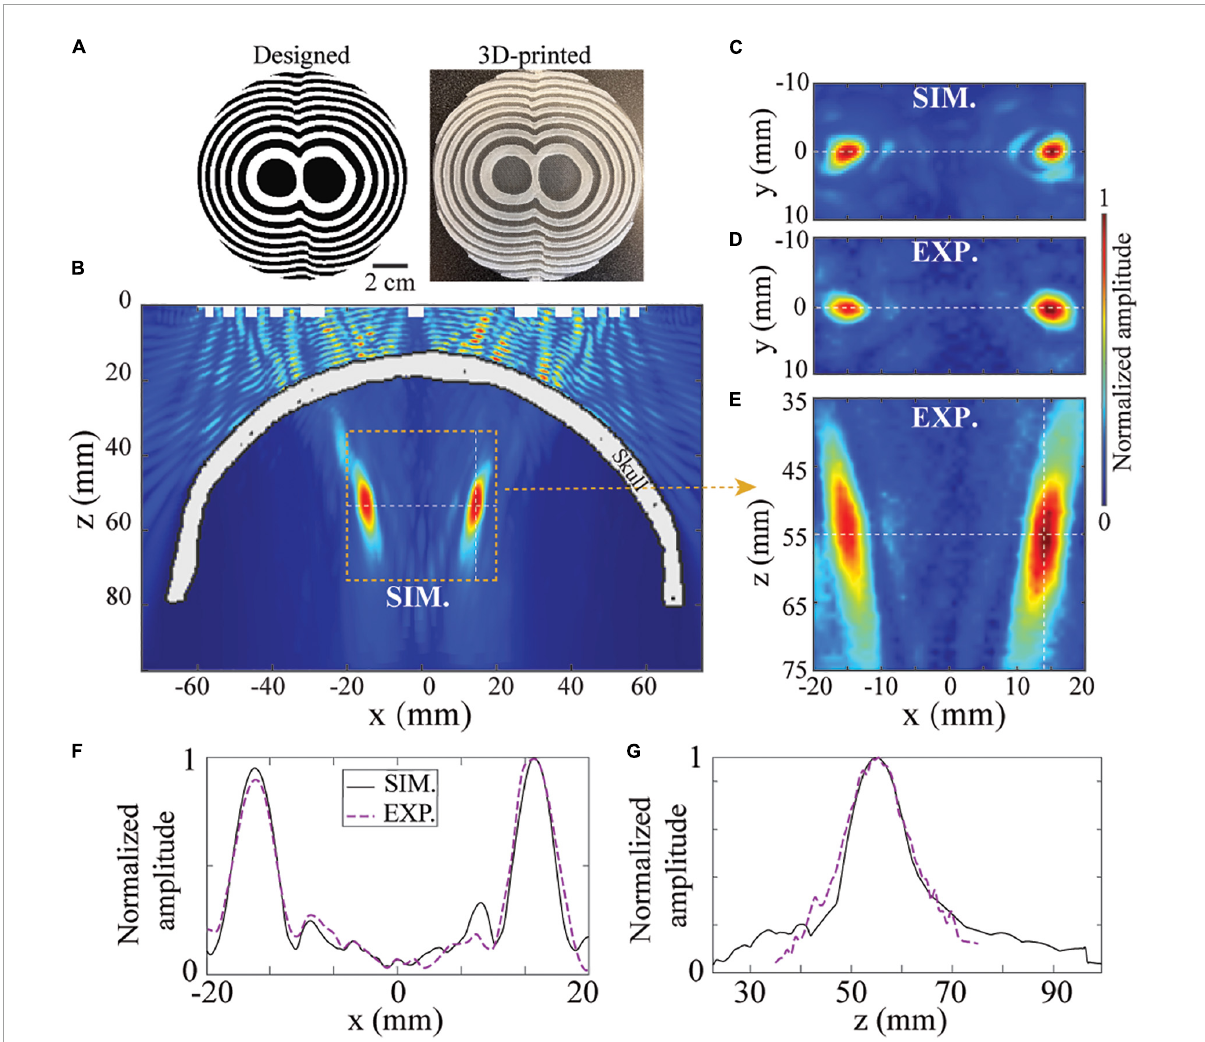
FIGURE5 BAM for tFUS bifocal focusing. (A) The designed and 3D-printed BAM for bifocal focusing at z = 55 mm. The ultrasound field in the xz-plane by simulation (B) and experiment (E) . (C,D) Corresponding xz-plane of ultrasound field. (F,G) Simulated and experimentally measured axial and lateral pressure